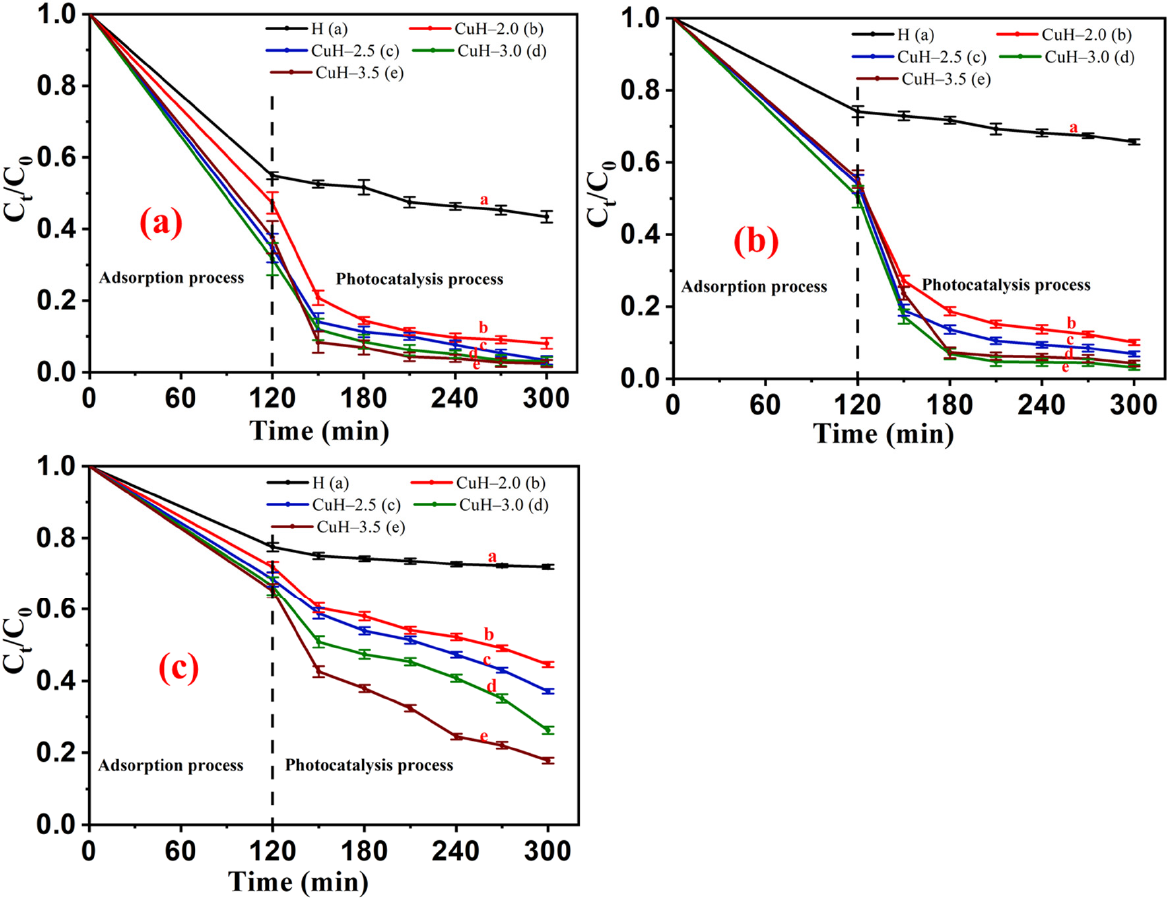
Figure 8. PR adsorption and photocatalysis process at concentrations of 50 ppm ( a ), 75 ppm ( b ), and 100 ppm ( c ) on the hydrotalcites.